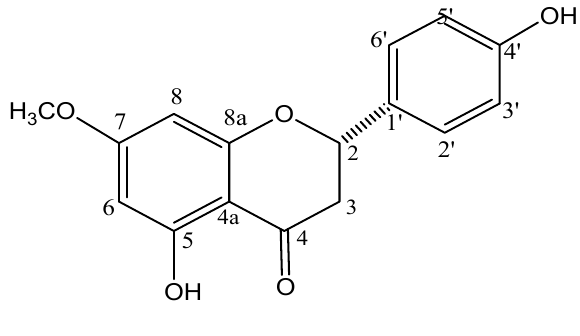
Figure 1. Chemical structure of 5,4'-dihydroxy-7-methoxy-flavanone (sakuranetin).